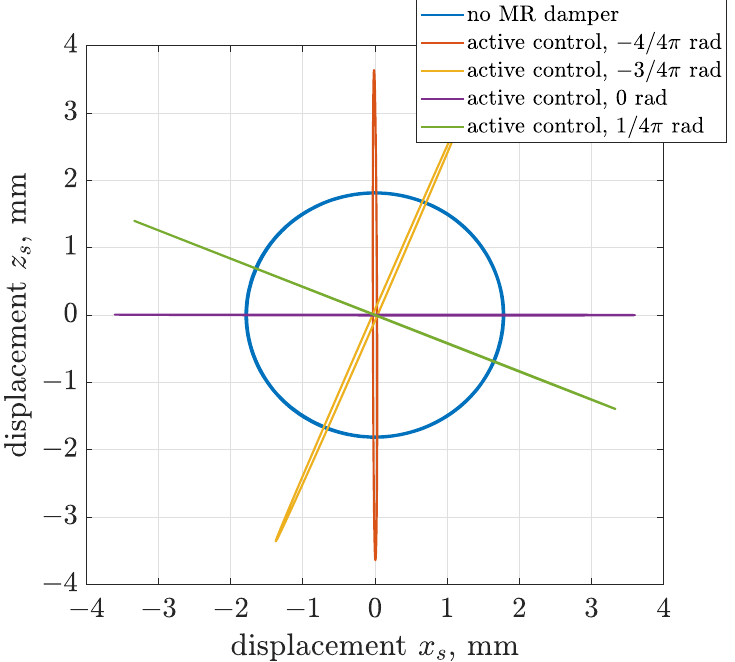
Figure 23. Different configurations of phase shift ∆ α alg dedicated to active generation of linear trajectories of vibration